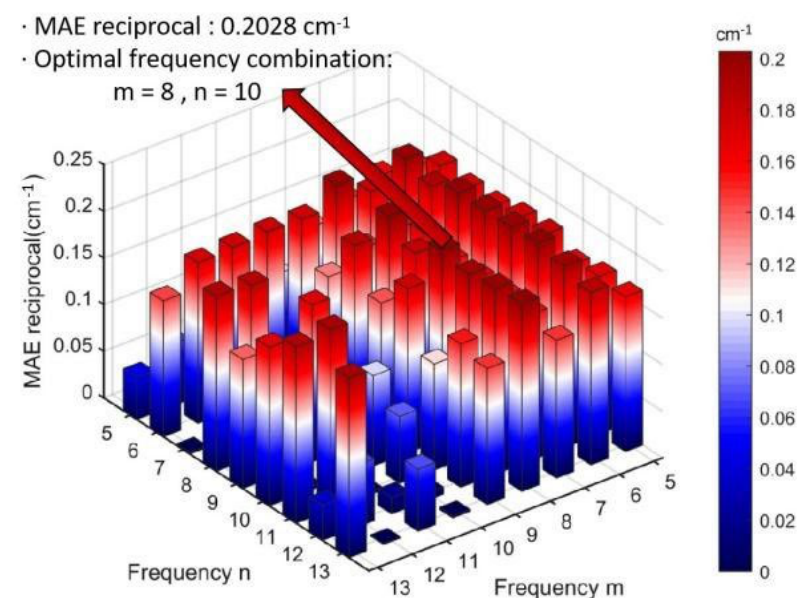
Figure 5. ( a ) A created artificially ideal stationary eddy whose resolution is 0.01° × 0.01°. ( b ) The location of the along-track data corresponding to the simulated eddy.